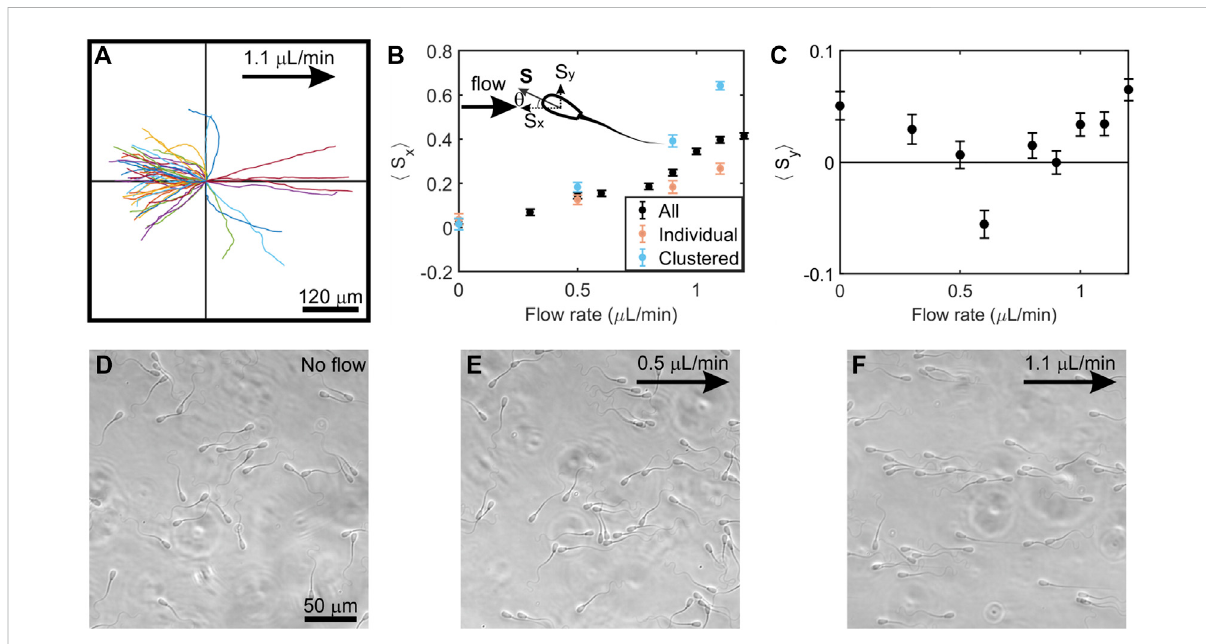
Behaviorofspermswimming inalow-speed fl owofviscoelastic fl uid. (A) ,Ina1.1 μ l/min fl ow,spermshowedlinear trajectorieswhenswimming both upstream (upper and lower left quadrants) and downstream (upper and lower right quadrants)( N = 50trajectories; each trajectory is 4.5 slong) (B) , The vector mean of the orientation of all sperm, clustered, and individual sperm along the x -axis ( 〈 S x 〉 ) at increasing fl ow rates. Upper left: schematic ofspermhead orientation denoted byaunitvector S ,where θ istheangle tothe x -axis. S x and S y isanorientationofsperm alongthe x -axisand y -axisrespectively. 〈 S x 〉 =0impliesrandomswimmingalongthe x -axiswhile 〈 S x 〉 =1impliesperfectalignmentofspermin x -axis. (C) ,The vector means of the orientation of all sperm along the y -axis ( 〈 S y 〉 ) at increasing fl ow rates. Three experiments (n = 3) from semen samples of three bulls were carried out, and each point represents N ≈ 800 – 1,100 tracked sperm cells. Each data point in the fi gure denotes the mean of three experimentsanderrorbarsrepresentthestandarderrorsofthemean. (D) , (E) , (F) ,Photomicrographs(264×264 μ m)ofspermswimmingatno fl ow, 0.5 μ L/min, and 1.1 μ L/min, respectively. Flows are applied toward the positive x -direction and denoted by an